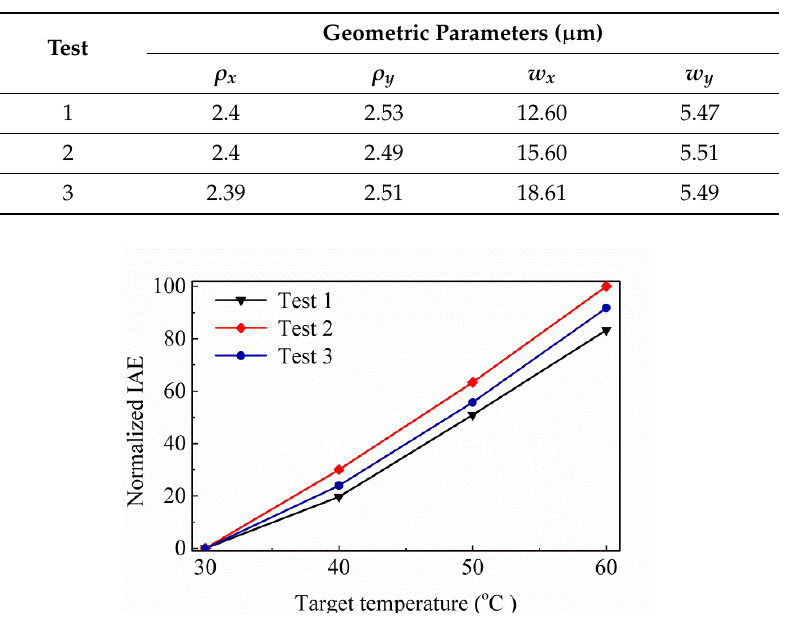
Figure 9. N ormalized IAEs normalized by the maximum of test 2 case for three trial thermopiles. Table 3. Measurement results for the geometric parameters of three proposed